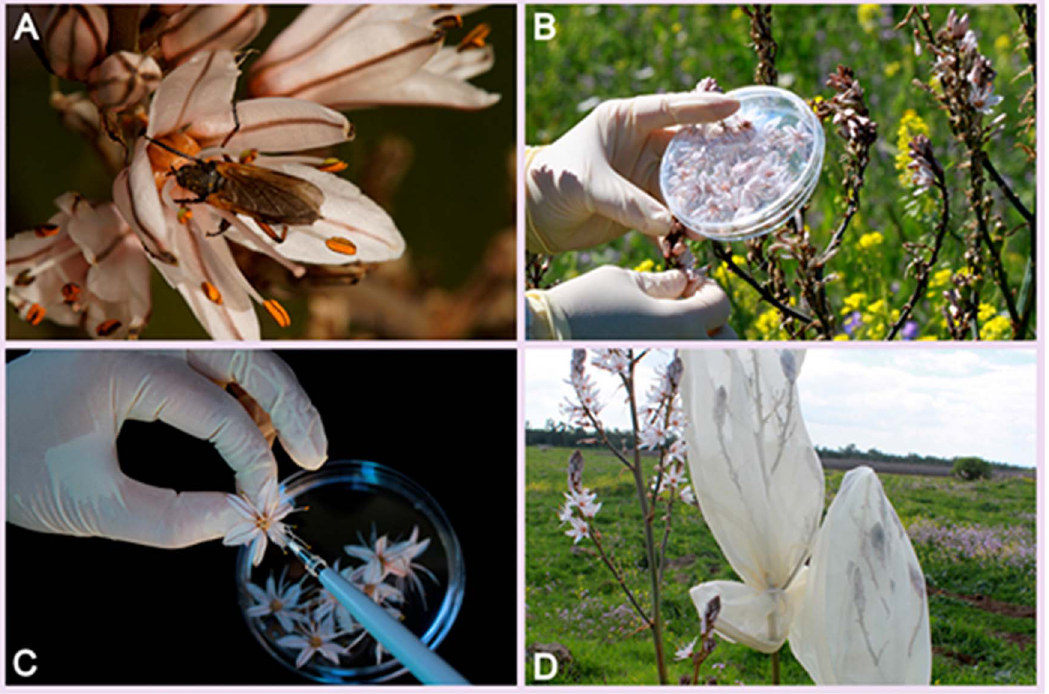
Figure 1. Asphodelusaestivus . A, Flower and a consumer fly ( Eempidoidea ); B, Flower collection; C, Nectar collection; D, Bagged inflorescences. doi:10.1371/journal.pone.0099107.g001 PLOS ONE |